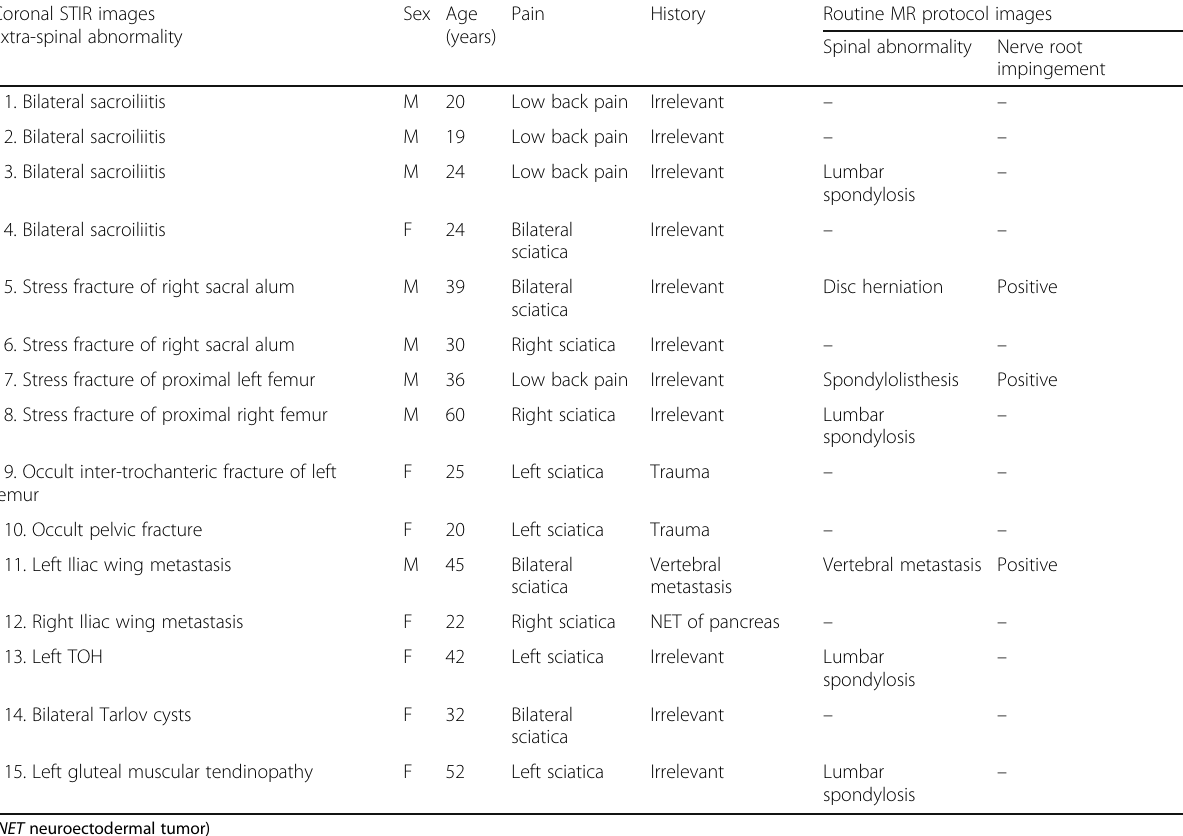
Table 2 Extra-spinal abnormalities detected on coronal STIR images, explain the patients ’ pain and influence their management Coronal STIR images Extra-spinal abnormality